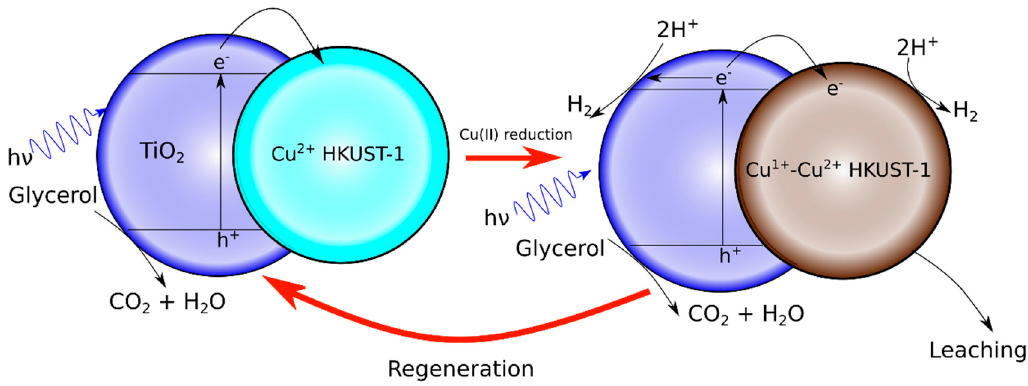
Figure 7. Proposed photocatalytic mechanism of glycerol photoreforming with the TiO 2 P25 / syn-HKUST-1 under solar light irradiation.